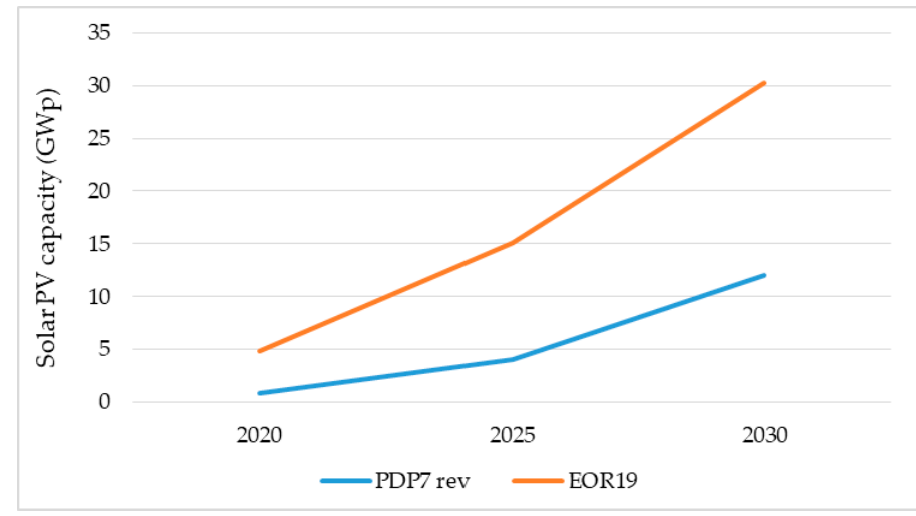
Figure 15. Total solar PV capacity planned in PDP7 rev and assumed by authors following EOR19.